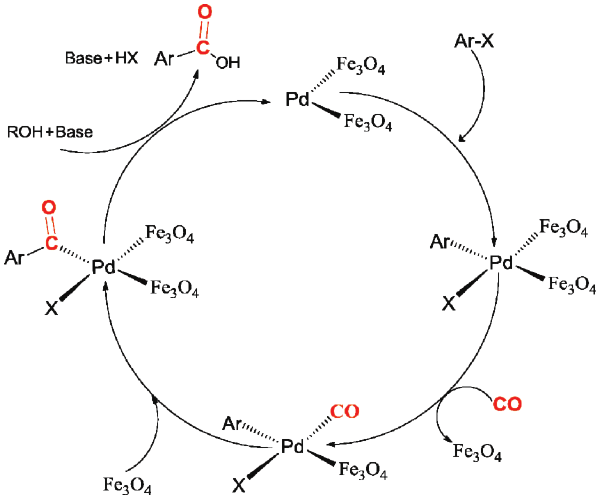
Figure 15 Role of magnetite in carbonylation of aryl halides by Pd(0)